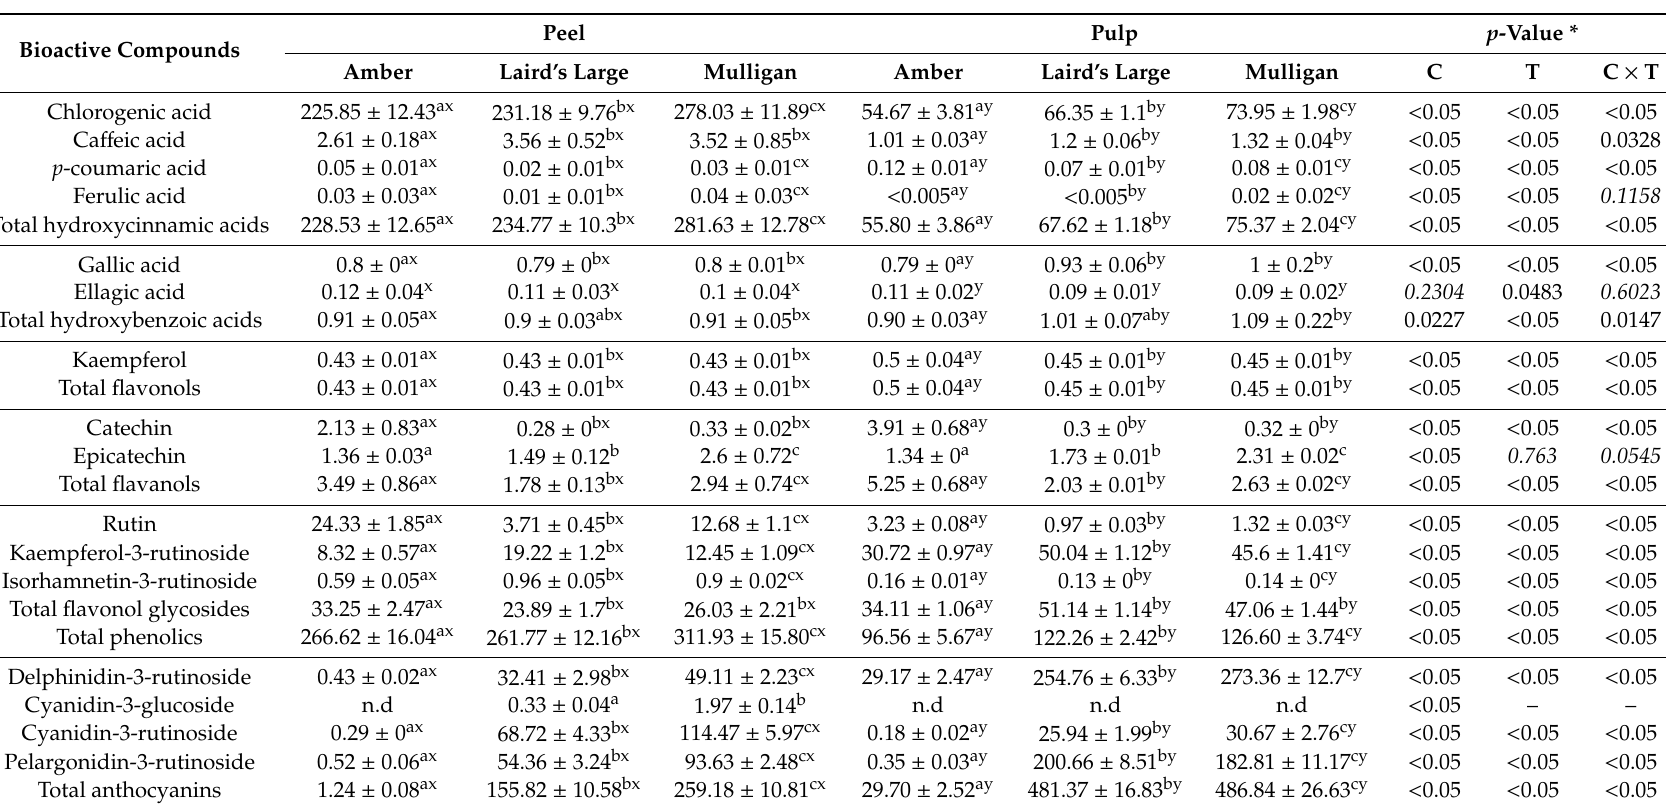
Table 1. Profiles of phenolics and anthocyanins (mg / 100 g DW) in three tamarillo cultivars, separated by cultivars and tissues. Values are expressed as Mean ± SD ( n =